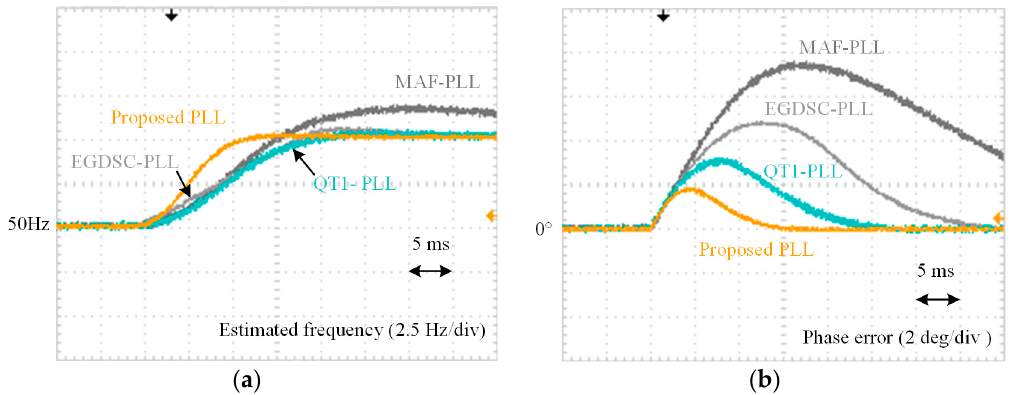
Figure 22. The experimental results of test case 2. ( a ) Estimated frequency and ( b ) phase